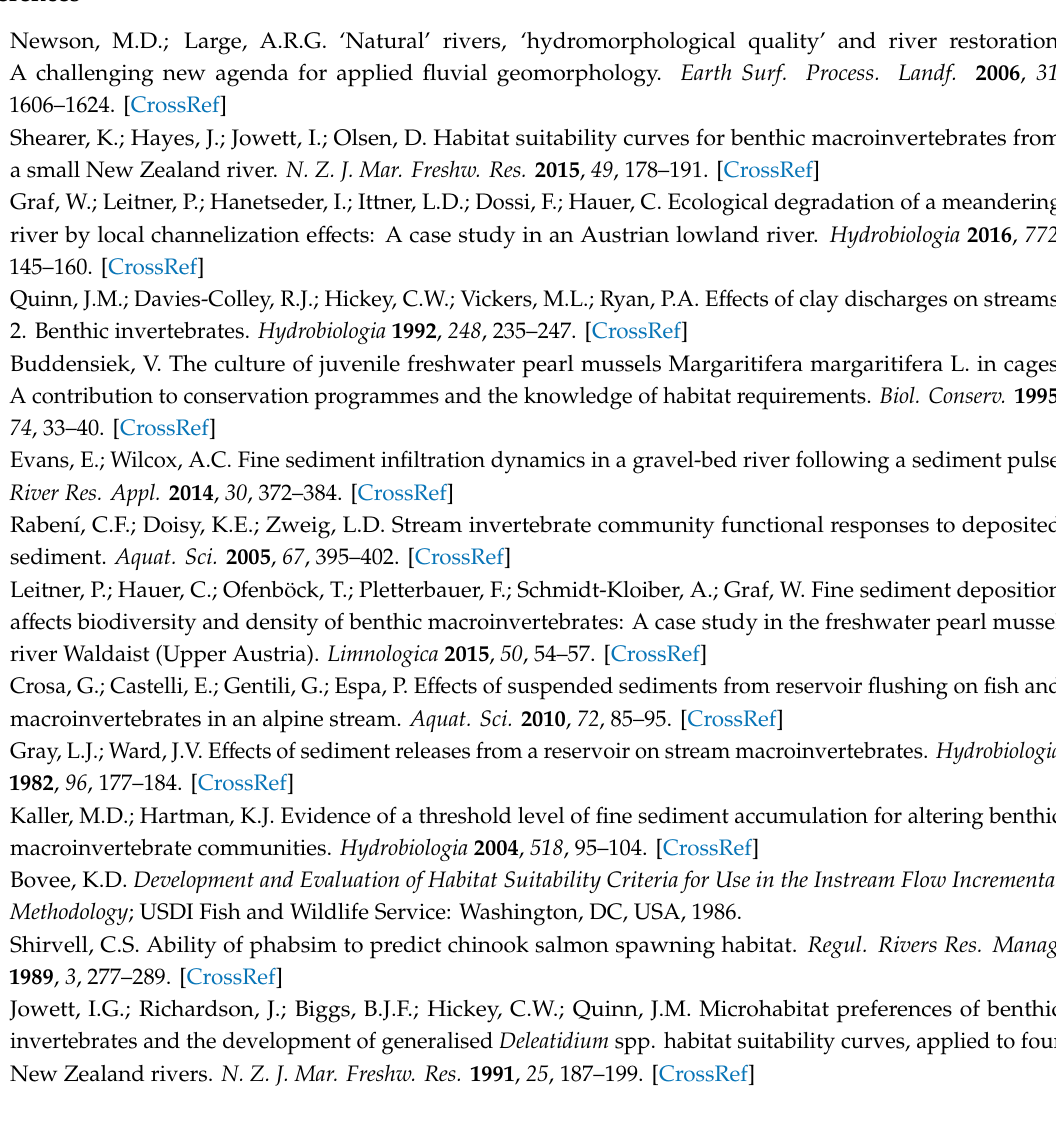
Figure S1: Correlation grain size d 50 —flow